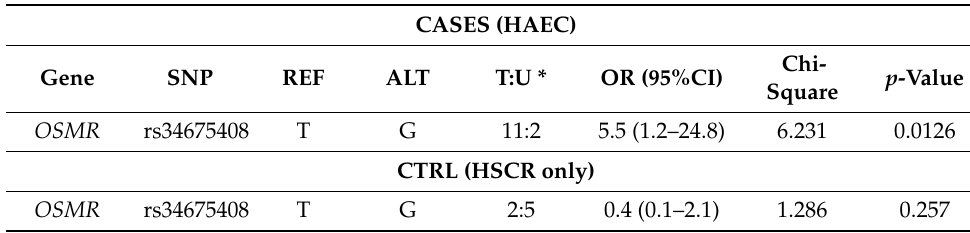
patients, which was transmitted 11 times out of 13 ( p = 0.0126), but not to HSCR-only patients (2 alleles transmitted out of 7) (Table 2). Table 2. Family-based association performed on the Oncostatin-M receptor ( OSMR ) Single Nucleotide (HSCR) Associated Enterocolitis (HAEC) and HSCR-only available trios. CASES